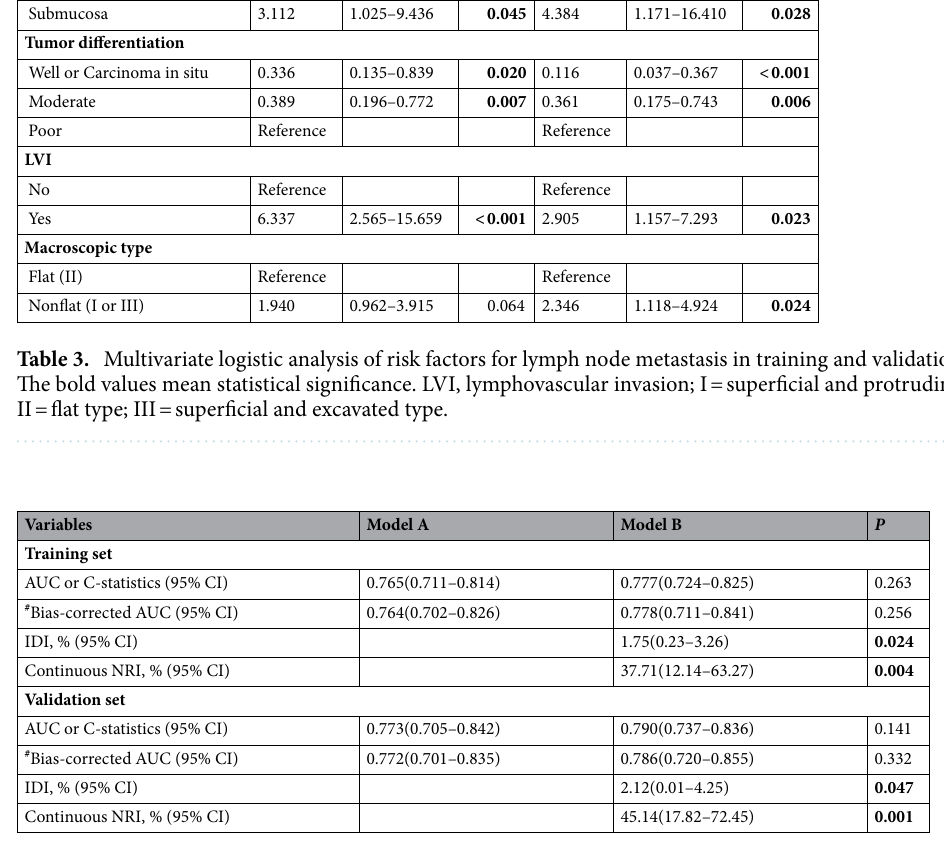
Table 4. Accuracy of the prediction model based on multivariate logistic analysis for estimating the risk of LNM presence. The bold values mean statistical significance. Model A = tumor size + tumor invasion depth + tumor differentiation + lymphovascular invasion; Model B = tumor size + tumor invasion depth + tumor differentiation + lymphovascular invasion + macroscopic type. AUC area under curve, IDI integrated discrimination improvement, NRI net re-classification improvement. # Bias-corrected AUC: it was calculated by using R software version 4.0.3 with pROC package (method = bootstrap, n =